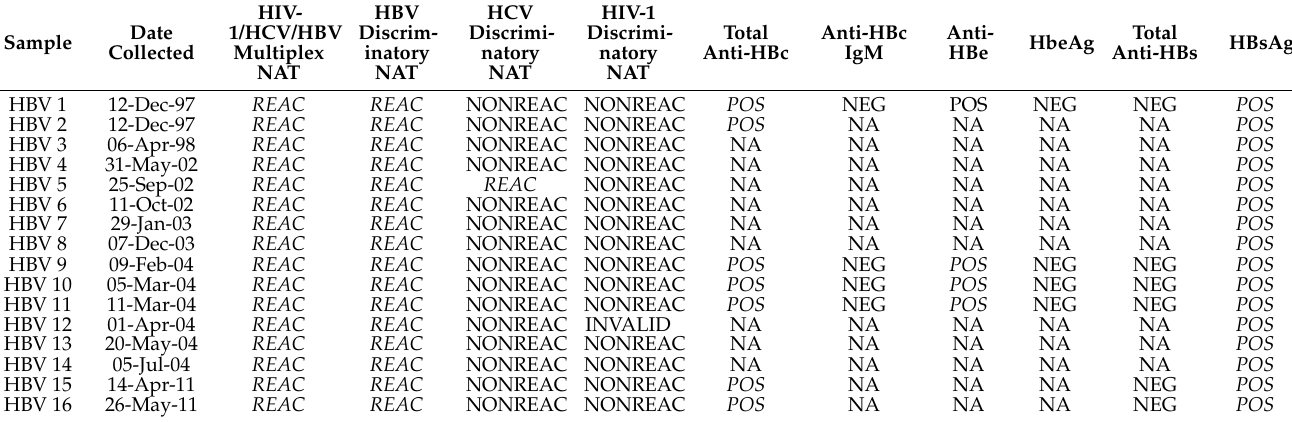
Table 1. Characteristics of the HBV plasma samples